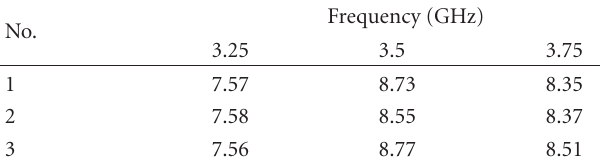
Table 2: The measured gain of the quasi-Yagi antenna (unit: dBi). No.